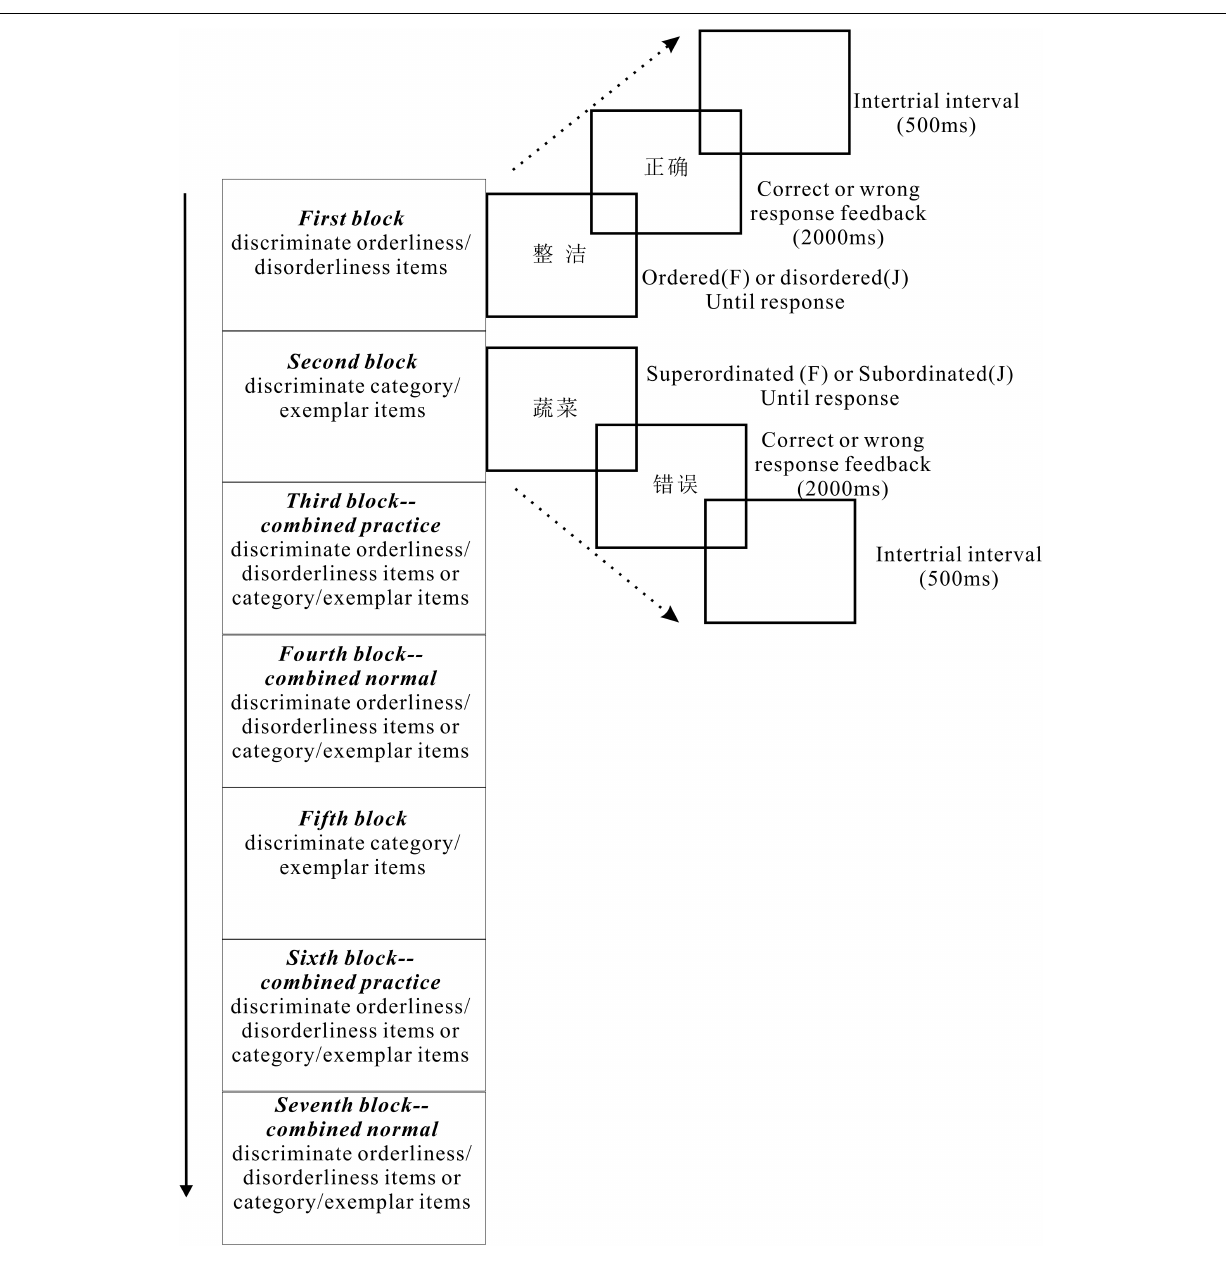
FIGURE 1 | Illustration of the procedure for experiment